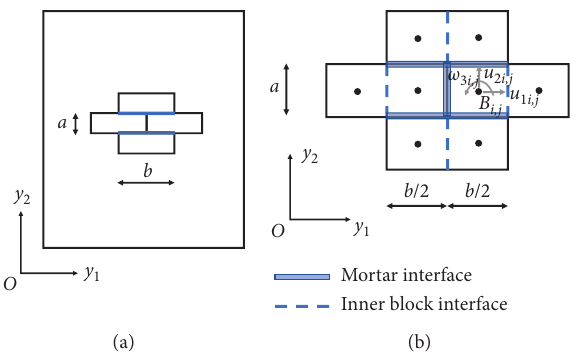
Figure 1: Refined rigid block model for regular